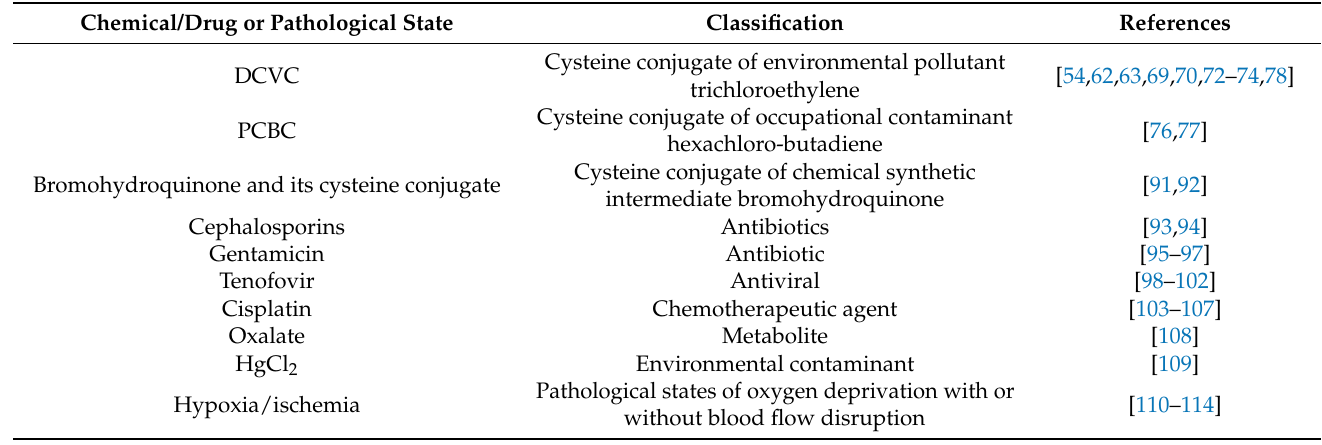
Table 2. Selective list of chemicals and drugs whose nephrotoxicity is associated with mitochondrial dysfunction. Chemical/Drug or Pathological State